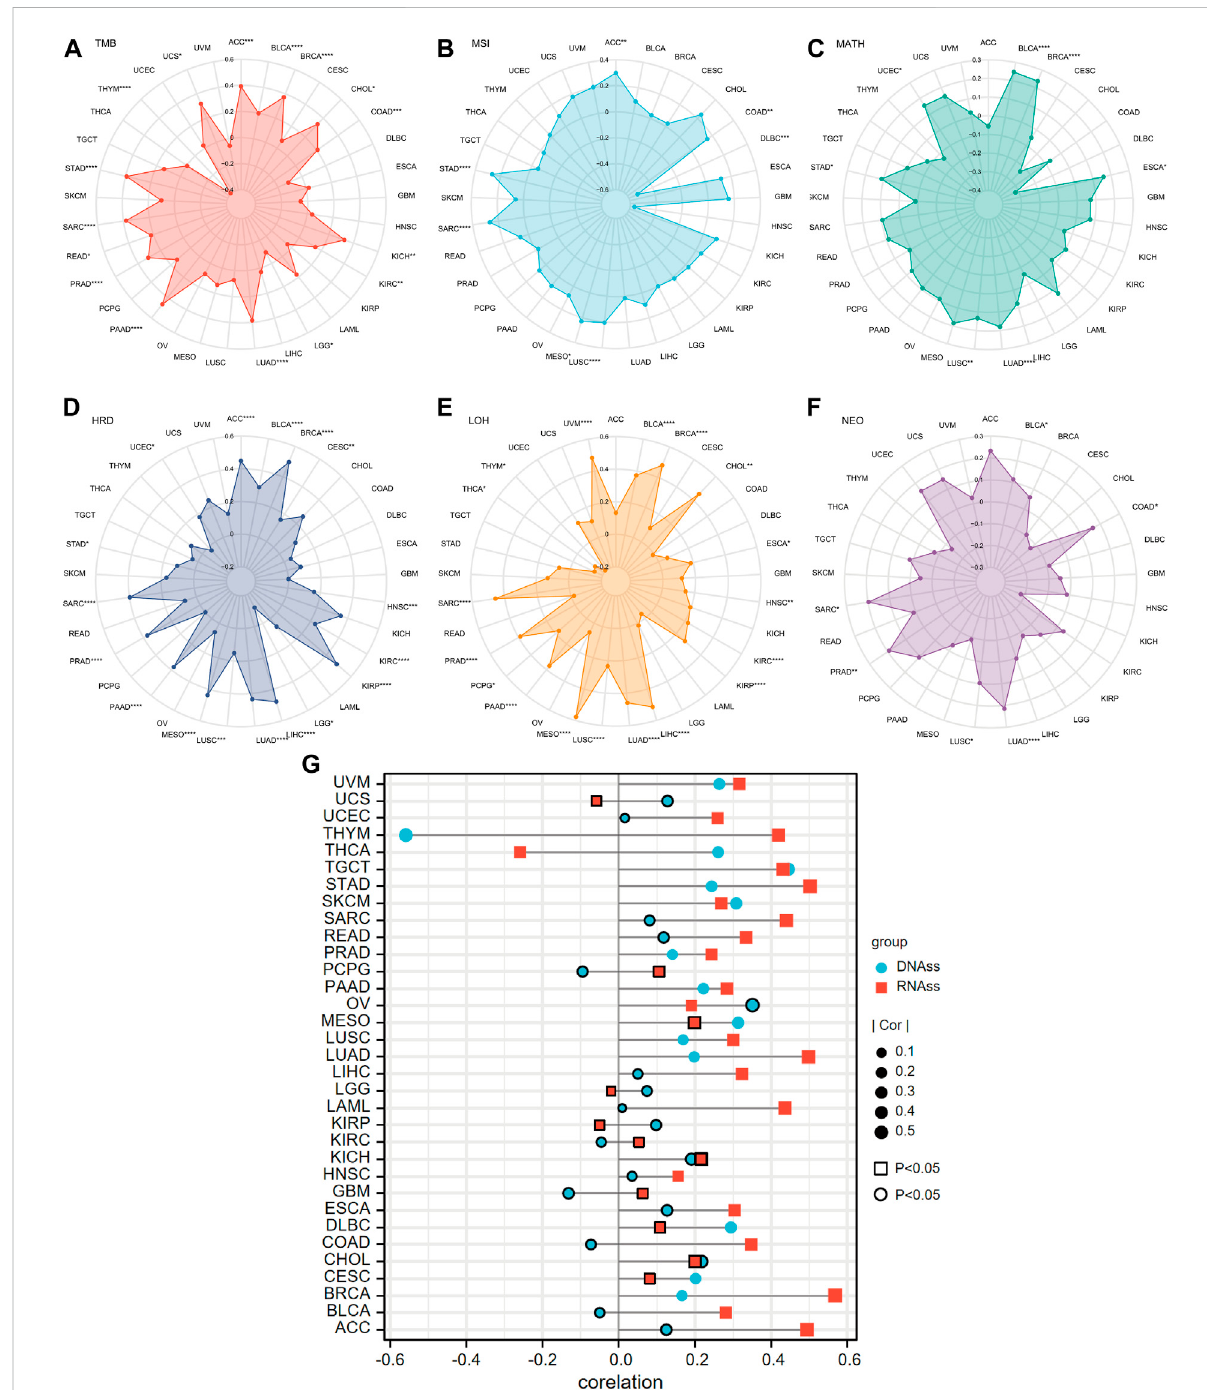
FIGURE 14 Correlations of ANLN expression and tumor heterogeneity including (A) TMB; (B) MSI; (C) MATH; (D) HRD; (E) LOH; (F) NEO in pan-cancer. (G) Correlation of tumor stemness and ANLN expression in pan-cancer. Different shapes and colors represent different tumor stemness indexes. The graph without peripherally bolded means a p -value of less than